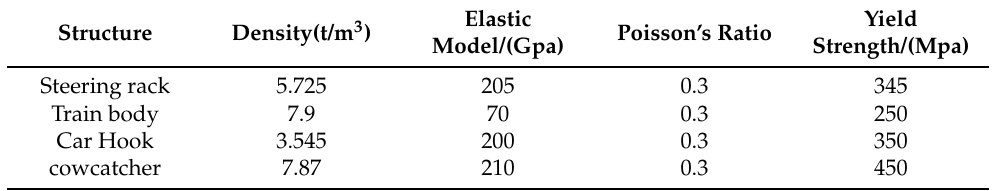
Table 6. Train material